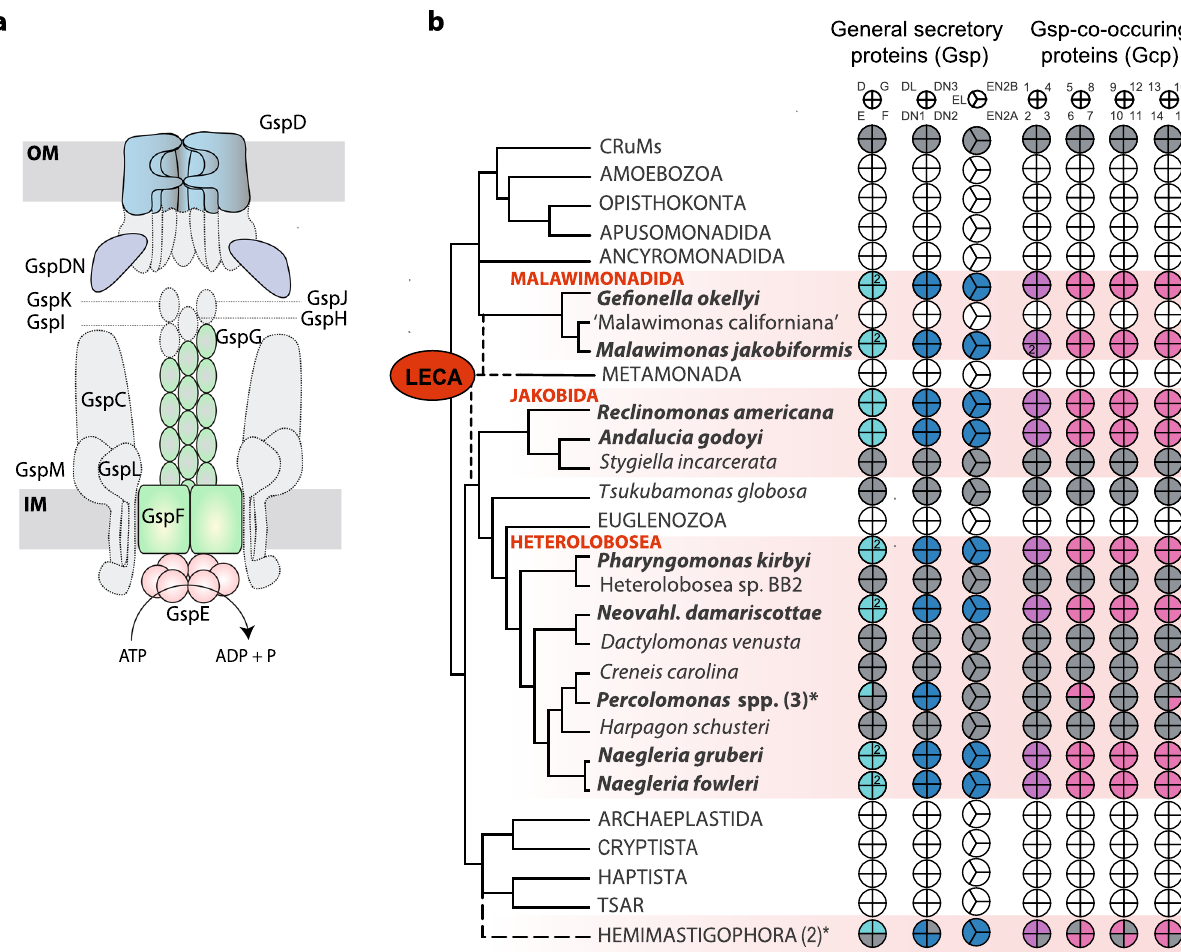
Fig. 1 Some eukaryotes harbour homologues of core components of the bacterial T2SS machinery. a Schematic representation of the complete bacterial T2SS; subunits having identi fi ed eukaryotic homologues are highlighted in colour. For simplicity, GspDN represents in the fi gure three different eukaryotic proteins (GspDN1 to GspDN3), together corresponding to two versions of a conserved domain present as a triplicate in the N-terminal region of the bacterial GspD protein. b Phylogenetic distribution of eukaryotic homologues of bacterial T2SS subunits (Gsp proteins) and co-occurring proteins (Gcp). Core T2SS components (cyan), eukaryote-speci fi c T2SS components (dark blue), Gcp proteins carrying protein domains found in eukaryotes (magenta) and Gcp proteins without discernible homologues or with homologues only in prokaryotes (pink). Coloured sections indicate proteins found to be present in genome or transcriptome data; white sections, proteins absent from complete genome data; grey sections, proteins absent from transcriptome data. The asterisk indicates the presence of the particular protein in at least two of the three Percolomonas or at least one of the two Hemimastigophora species analyzed. The species name in parentheses has not yet been formally published. Sequence IDs and additional details on the eukaryotic Gsp and Gcp proteins are provided in Supplementary Data 1. The tree topology and taxon names re fl ect most recent phylogenomic studies of eukaryotes; 32, 101, 102 the root (LECA) is placed according to Derelle et al. 29